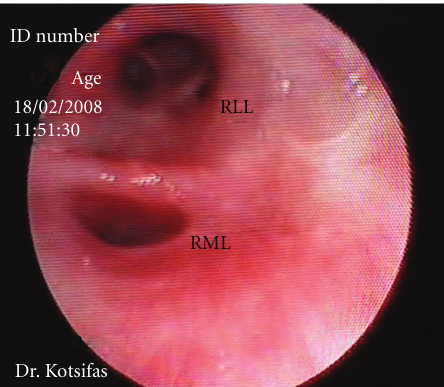
Figure 1: Endoscopic view from the lower part of the bronchus intermedius. The mucosa appears inflamed and slightly nodular at the level of the middle lobe bronchus, on the anteromedial wall. On the middle lobe carina, there is a discreet polypoid lesion. RML: right middle lobe bronchus. RLL: right lower lobe bronchus.